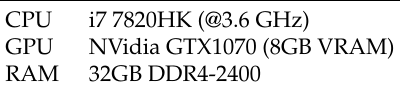
Table 2. Hardware used in the experiments.